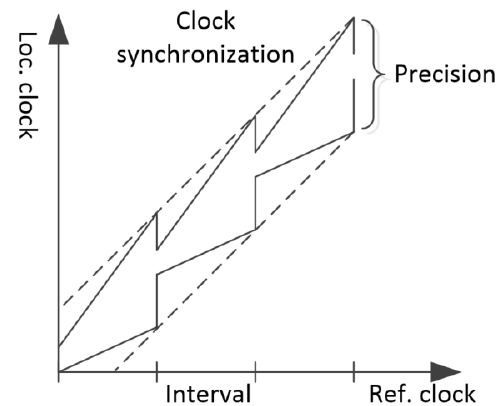
Figure 3. Clock synchronization between modules.